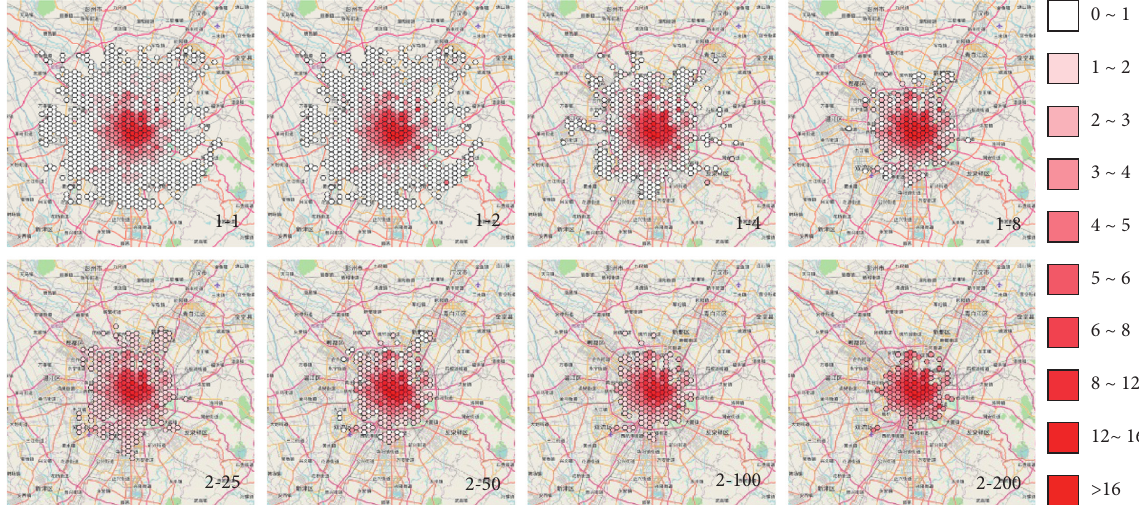
Figure 8: Spatial distribution of RMSE of the H-ConvLSTM model under different